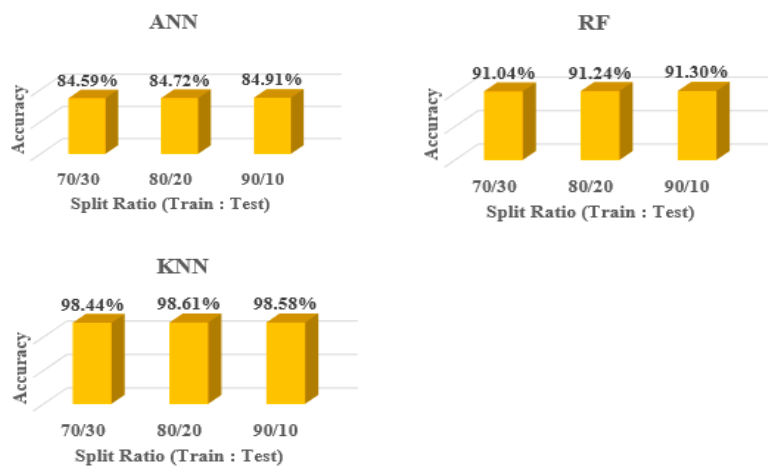
Figure 10. Accuracy of three split ratios (70:30, 80:20, and 90:10) of training vs. testing datasets.